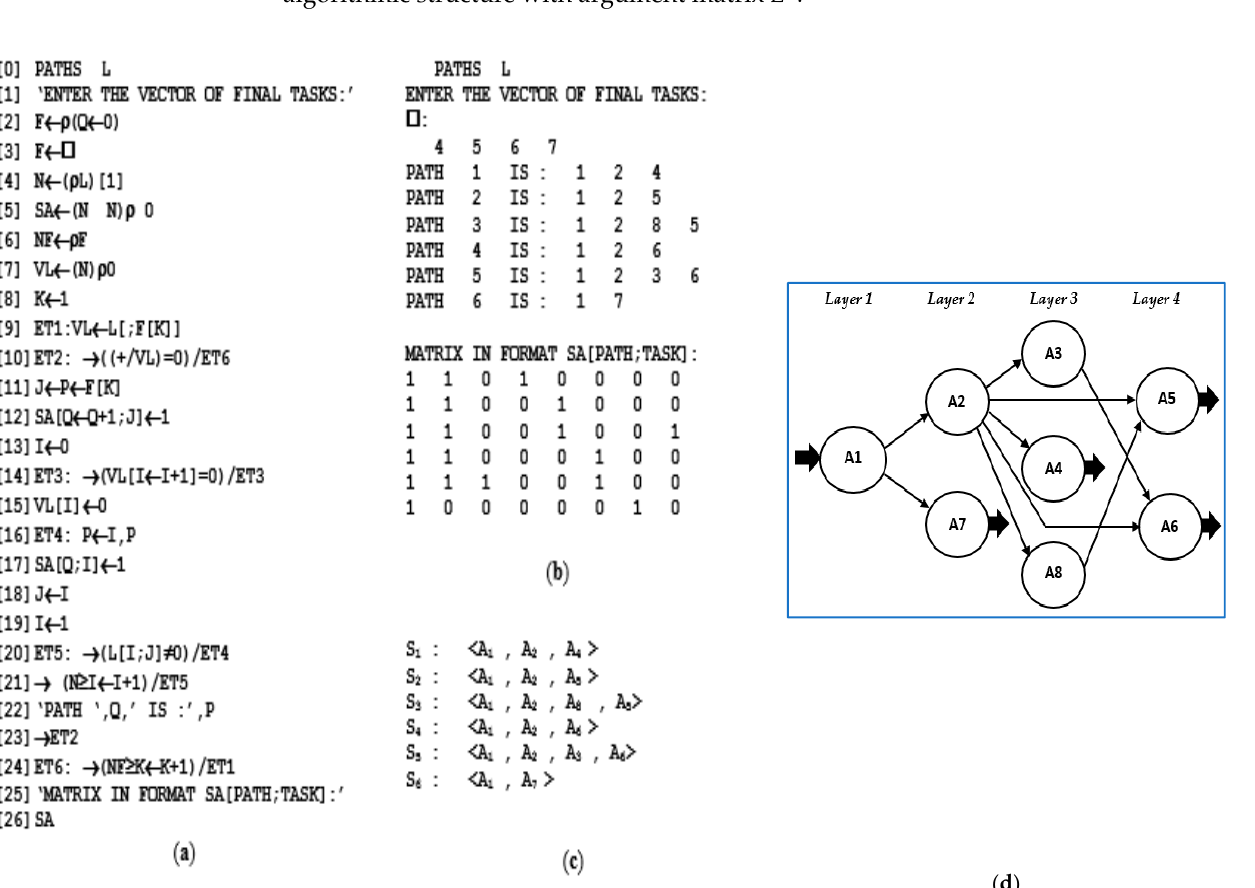
Figure 3. Program function PATHS—( a ) program code; ( b ) execution; ( c ) defined paths; ( d ) investigated ordered graph scheme of algorithm [1].